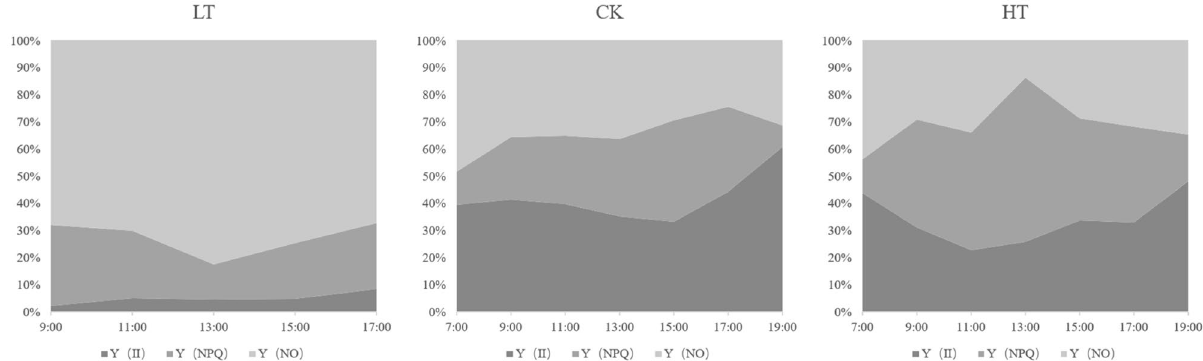
Figure 2. Light energy utilizations under different temperatures. Y (II): energy used for photosynthesis. Y(NO): PSII nonregulatory energy dissipation. Y (NPQ): PSII regulatory energy dissipation. The size of the areas in the graphs represents the energy proportion allocated to each part of the total absorbed